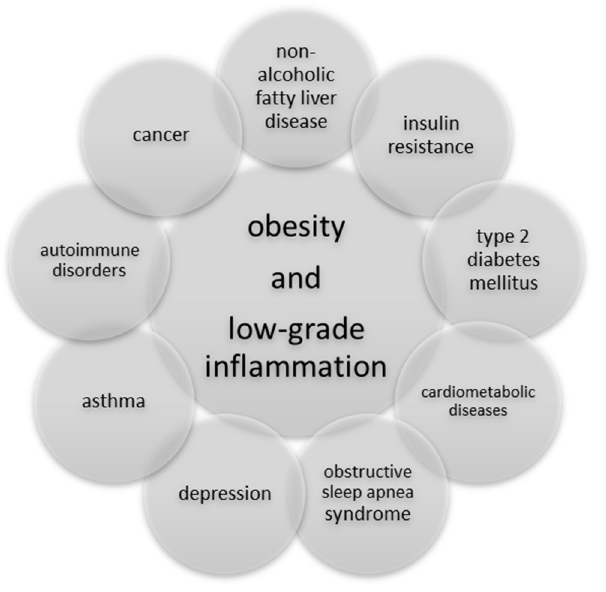
Figure 2. Possible consequences of low ‐ grade inflammation in childhood obesity.